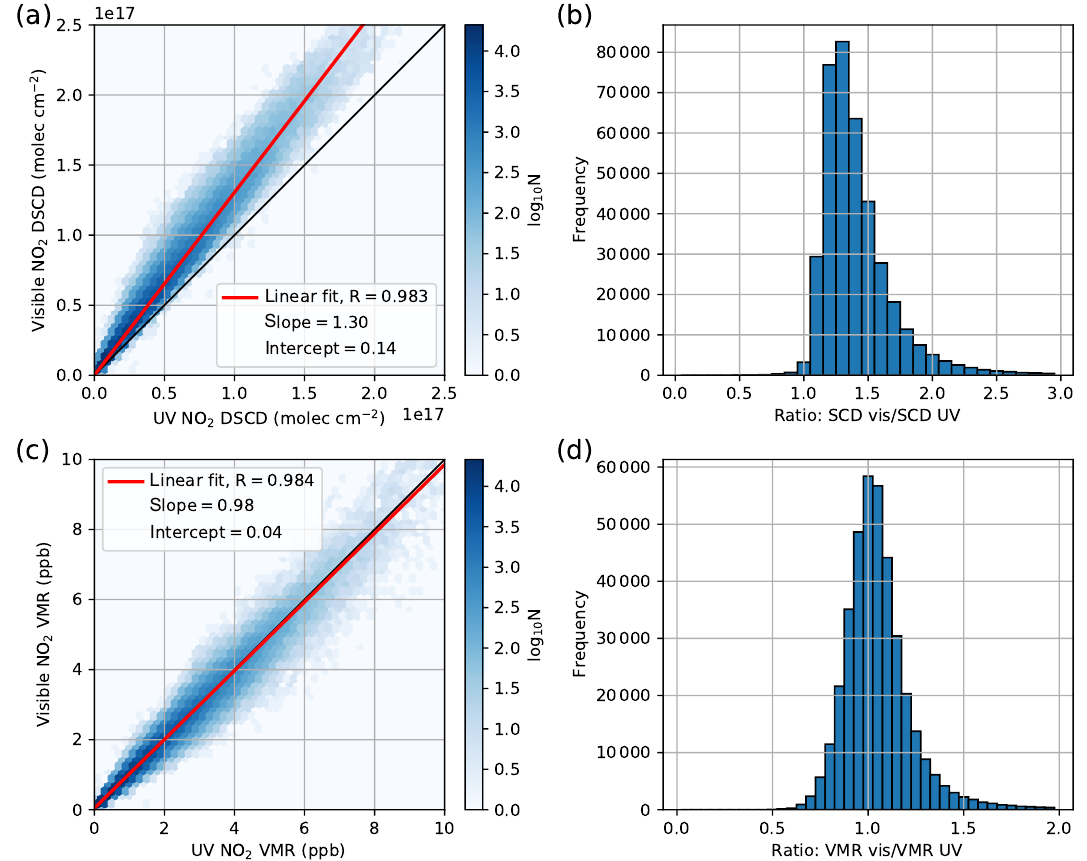
Figure 9. (a) Scatter plot: NO 2 slant column density retrieved in the visible vs. UV spectral ranges measured in all azimuth angles at 0.5 ◦ elevation for solar zenith angles smaller than 75 ◦ . The parameters derived from the linear fit by orthogonal distance regression (Deming regression) are also shown. (b) Histogram of the ratio of the two NO 2 slant column densities (visible / UV). Panel (c) is the same as panel (a) but for volume mixing ratios. (d) Histogram of the ratio of the two NO 2 volume mixing ratios (visible /